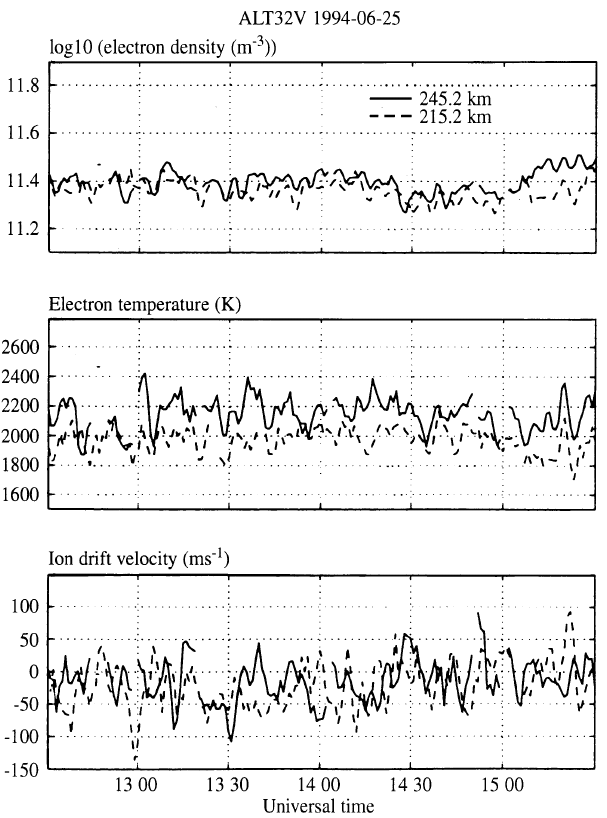
Fig. 3. The two parameters Q (cid:117) and Q (cid:100) of Eq. 1 as function of range and time from the analysis of the upshifted and downshifted plasma- line power